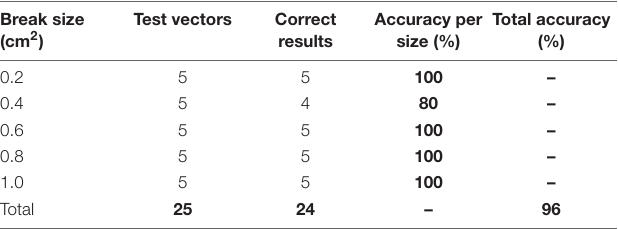
The bold values represent data statistics, intermediate diagnosis results, and final diagnosis